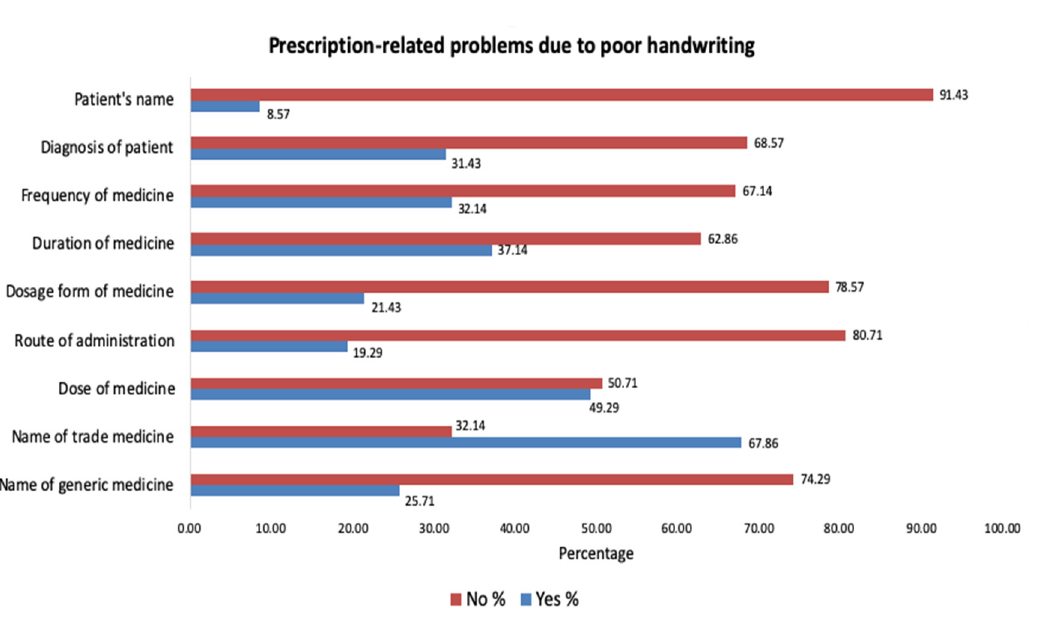
Figure 2. Problems encountered due to poor handwritten prescriptions.